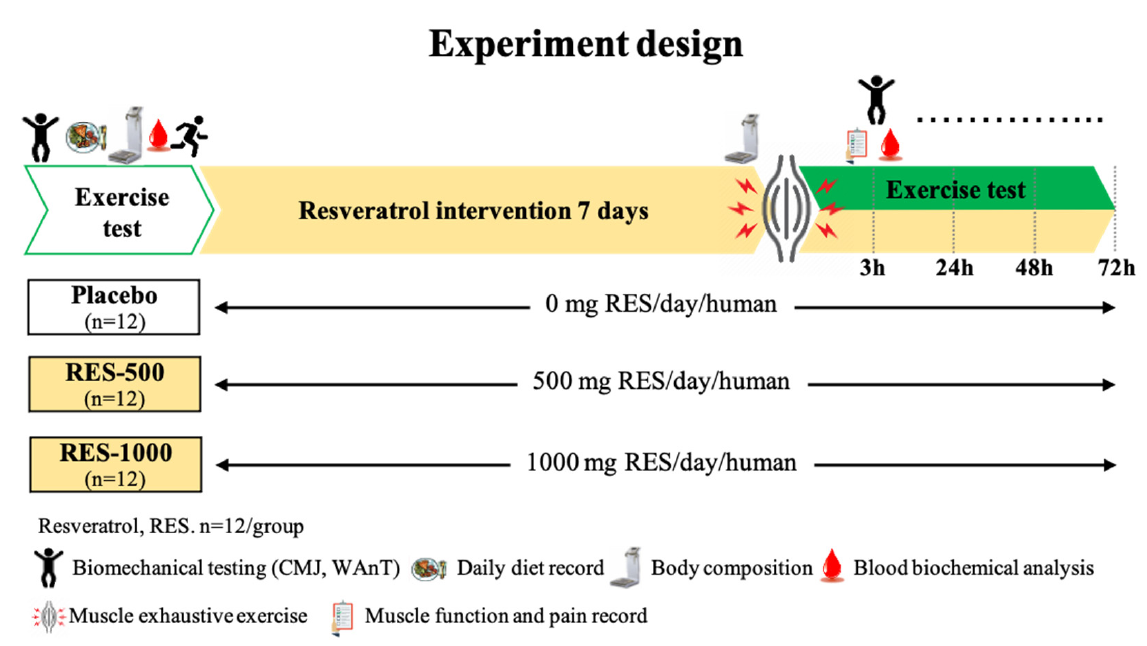
Figure 1. Experimental design overview: participants were supplemented for 10 days with placebo, 500 mg/day resveratrol (RES-500), or 1000 mg/day resveratrol (RES-1000), and an acute plyometric-exercise-induced muscle damage (PEIMD) protocol was conducted pre-PEIMD (day 7).